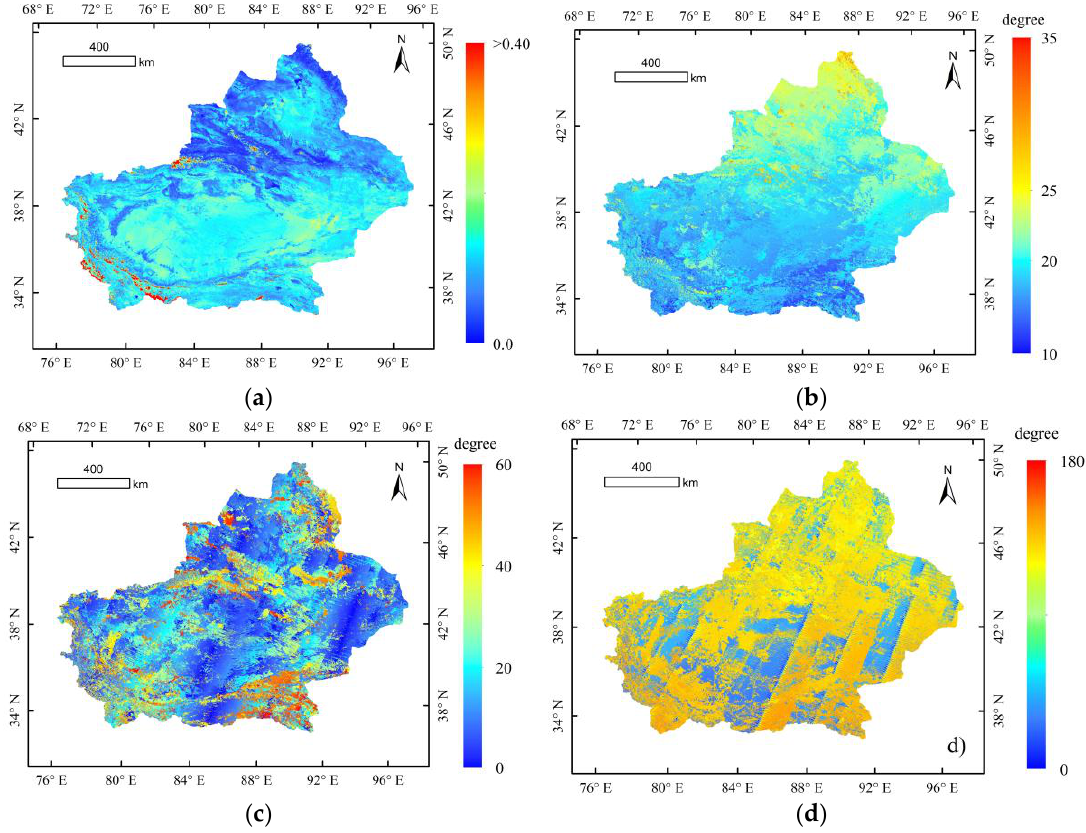
Figure 3. Example of a pre-calculated minimum land surface reflectance (MLSR) database using 5 years of MOD09A1 at 500 m resolution for July. ( a ): the surface reflectance at blue band; ( b ): the solar zenith angle; ( c ): the viewing zenith angle; ( d ): the relative azimuth angle.